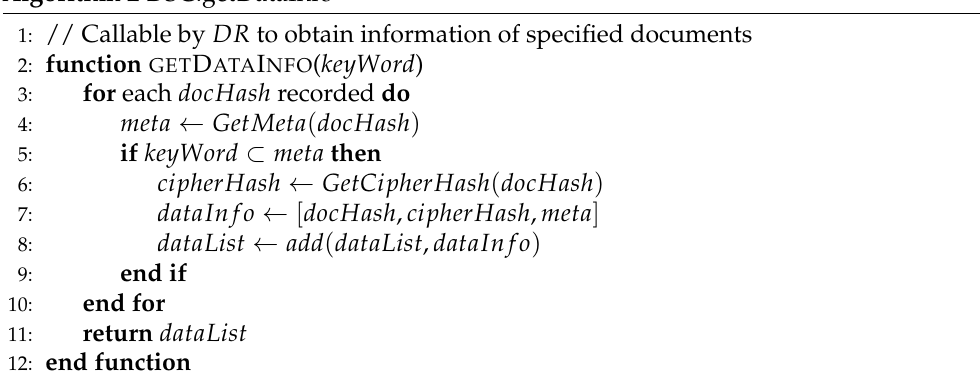
Algorithm 2 DSC.getDataInfo